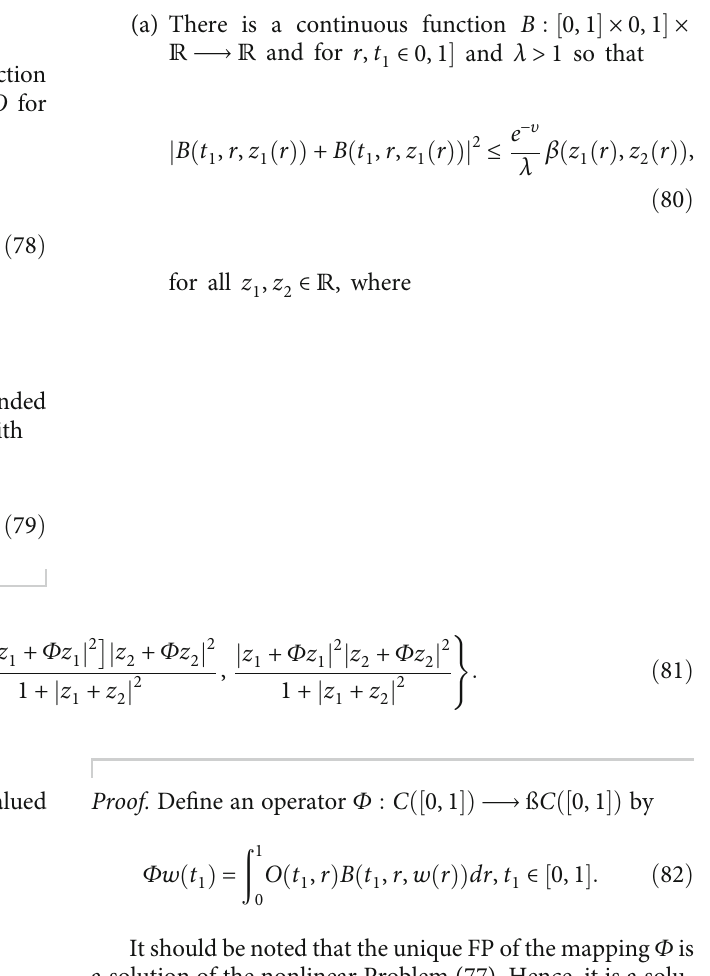
Figure 1: Forced